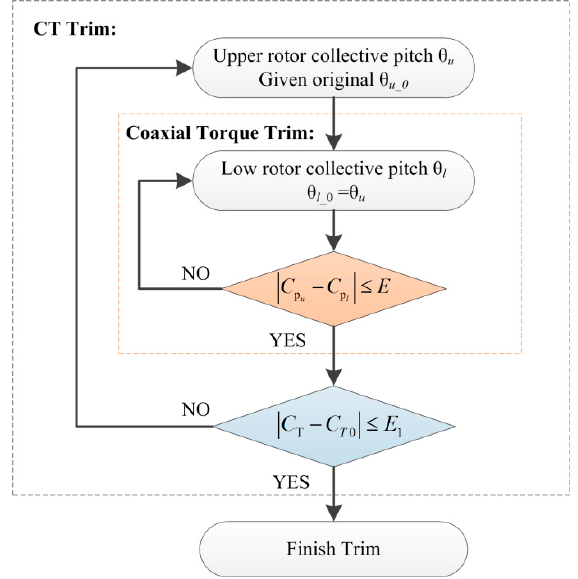
is the total thrust coefficient). T